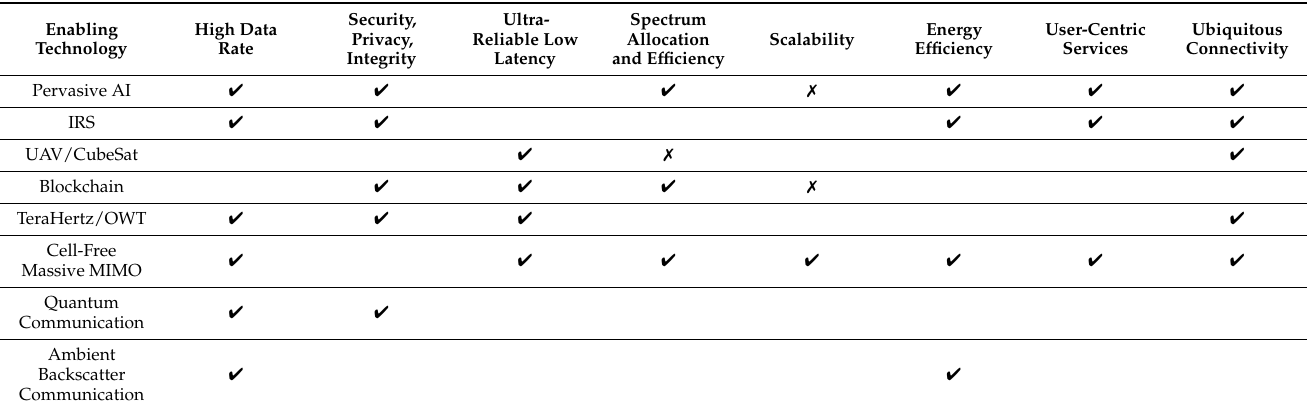
Table 14. Assessment of the enabling technologies and the desired requirements in